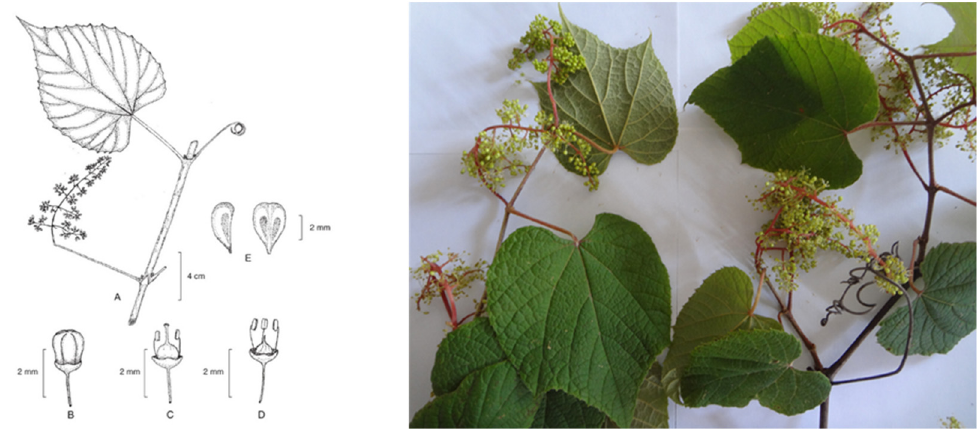
Figure 1. Vitis tiliifolia Humb. & Bonpl. ex Roem. & Schult. A, branch with leaf and inflorescence; B, flower bud; C, hermaphrodite flower devoid of three stamens; D, male flower devoid of two stamens; E. seeds in lateral and ventral view. Reproduced with some modifications from Ann. Missouri Bot. Gard. 55: 83. 1968. Copyright plantillustration.org. (public domain).